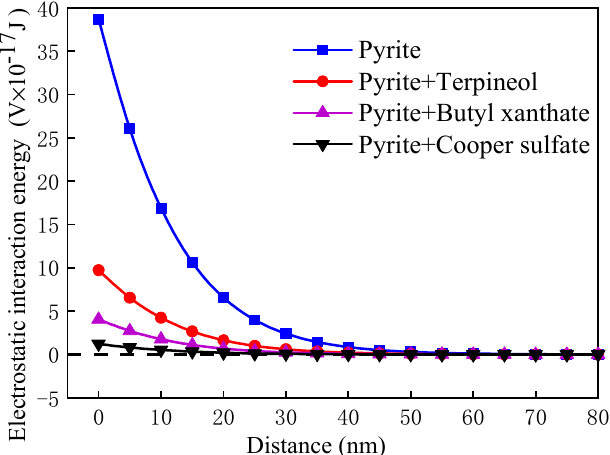
Figure 10. The electrostatic interaction energy between pyrite particles.